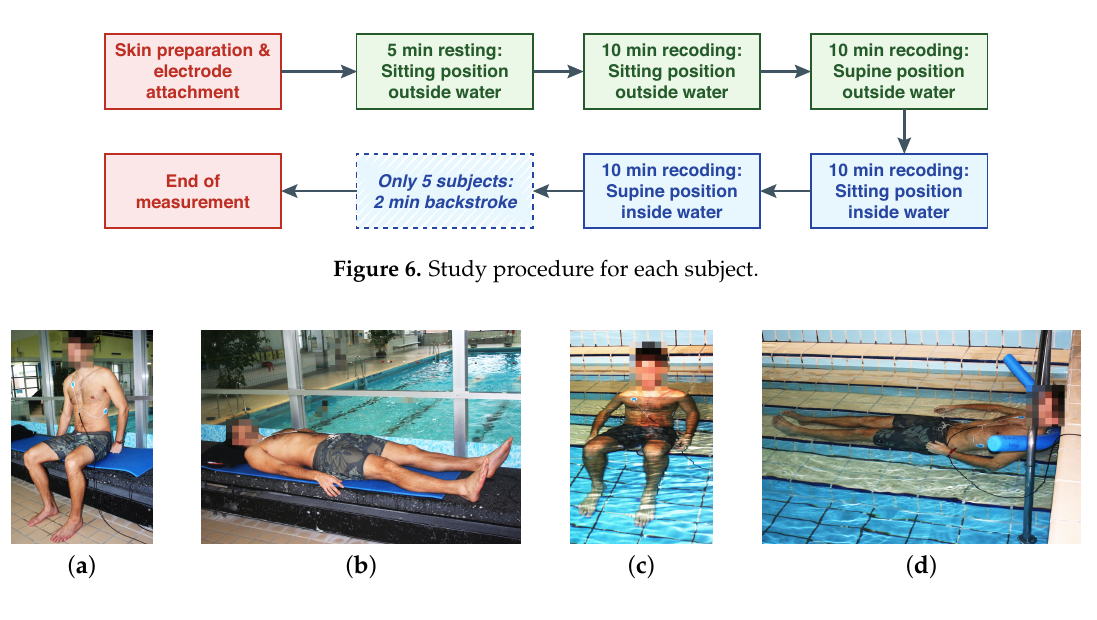
Figure 7. Positions of the subjects during the study. ( a ) Sitting position outside water. ( b ) Supine position outside water. ( c ) Sitting position inside water. ( d ) Supine position inside